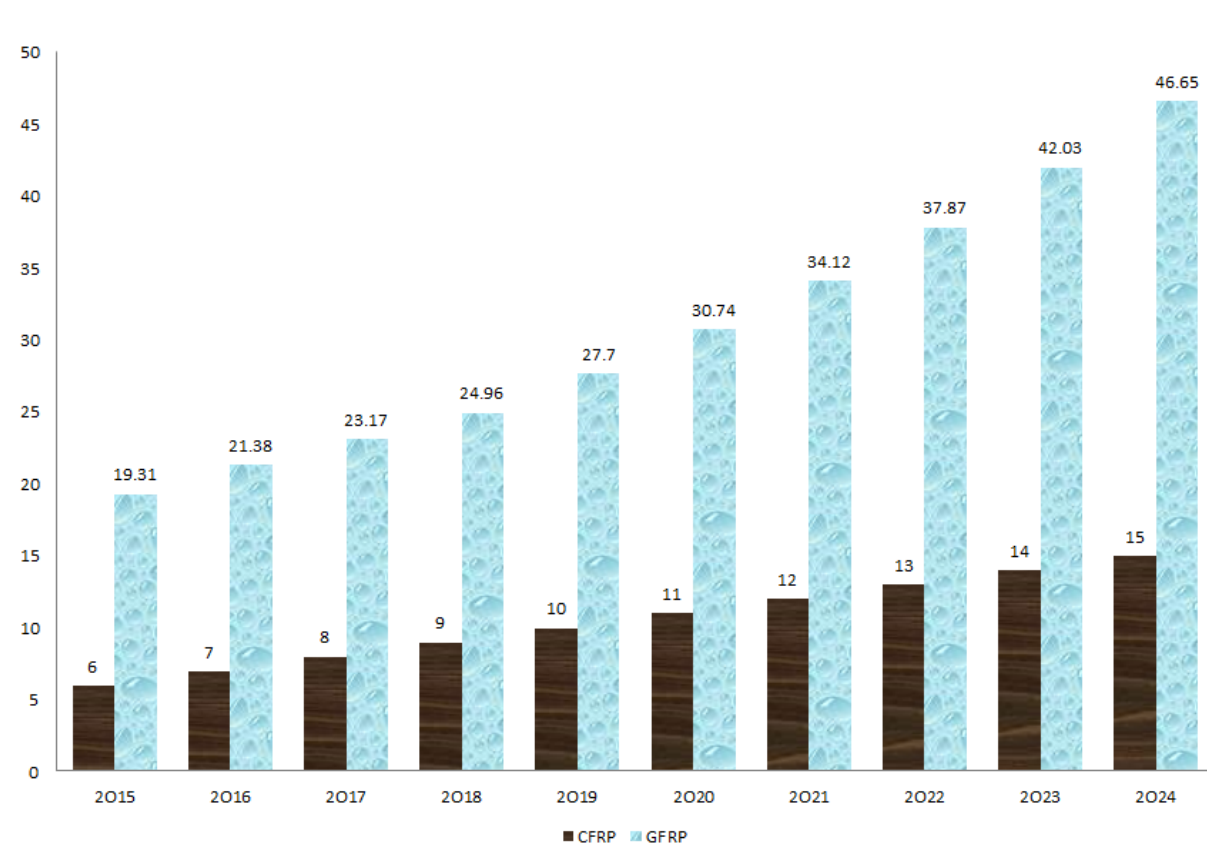
Figure 17. The growth diagram of the CFRP and GFRP composites market from 2015 to 2025 [198,199].